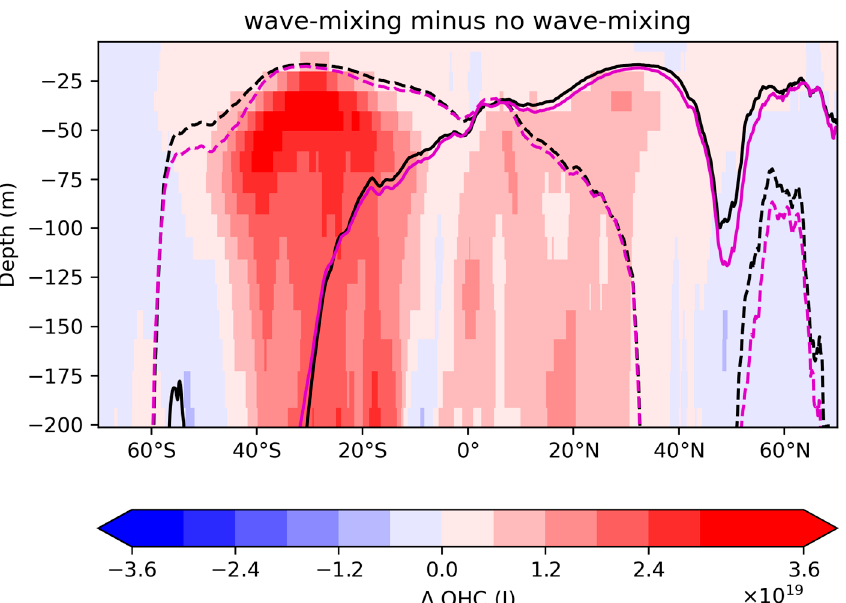
Figure 1. Wave-induced Ocean Heat Content (OHC) for present-day climate, shown by the difference between the control simulation and the wave-induced mixing simulation (wave-induced mixing minus control). Red indicates a wave-induced increase in OHC; blue indicates a decrease. Lines show the depth of the seasonal mixed layer: black lines are used for the control, purple lines are used for the wave-induced mixing simulation, dashed lines are used for the DJF months and solid lines are used for the JJA months. OHC is accumulated over all longitudes globally and mixed layer depth is a zonal average.